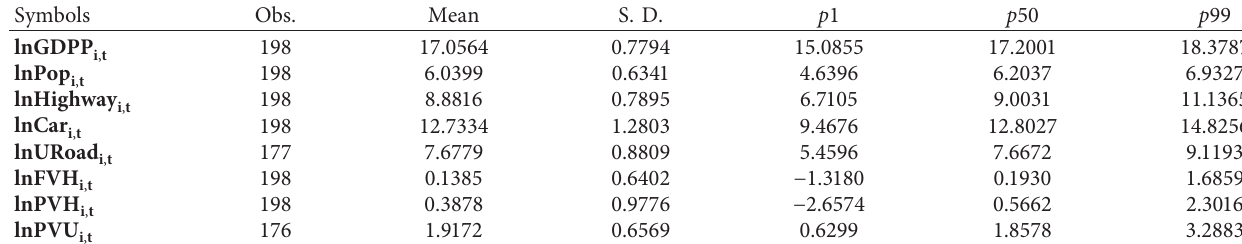
Table 4: The statistics of the control variables.